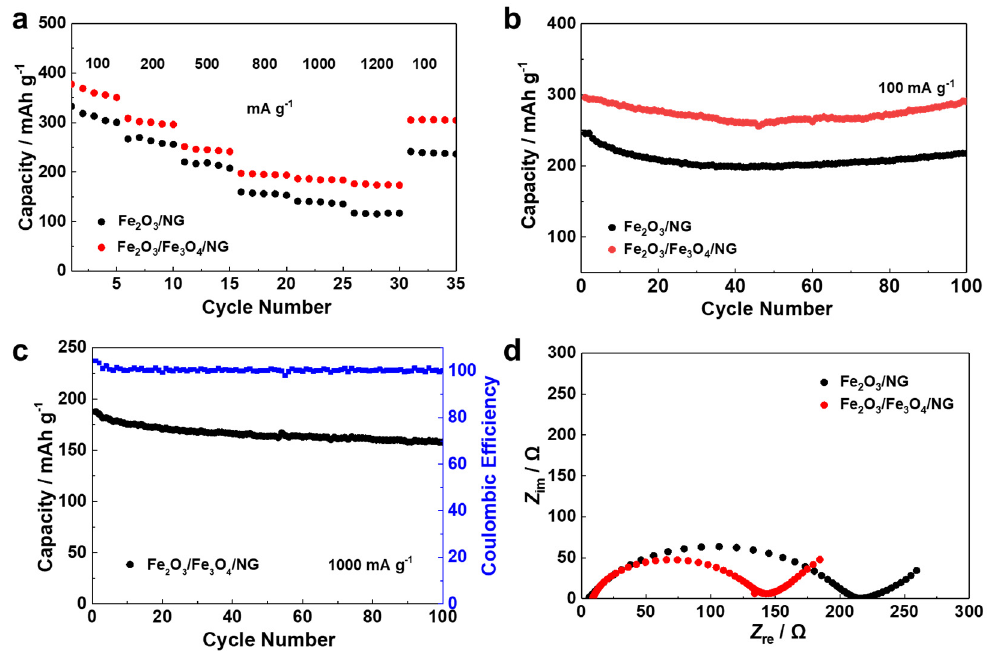
Figure 5. ( a ) Rate performance of Fe 2 O 3 /NG and Fe 2 O 3 /Fe 3 O 4 /NG tested at current densities from 100 to 1200 mA g − 1 . ( b ) Cycling performances of Fe 2 O 3 /NG and Fe 2 O 3 /Fe 3 O 4 /NG at current density of 100 mA g − 1 . ( c ) Cycling performance of Fe 2 O 3 /Fe 3 O 4 /NG at current density of 1000 mA g − 1 . ( d )